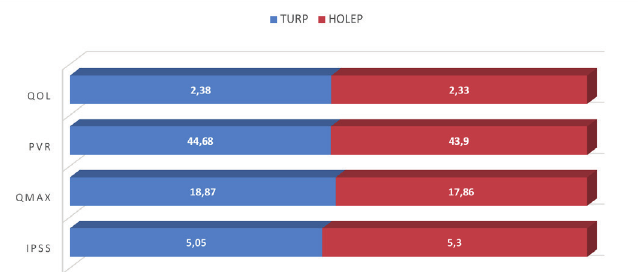
Figure 1 - Comparison of follow-up parameters at 3